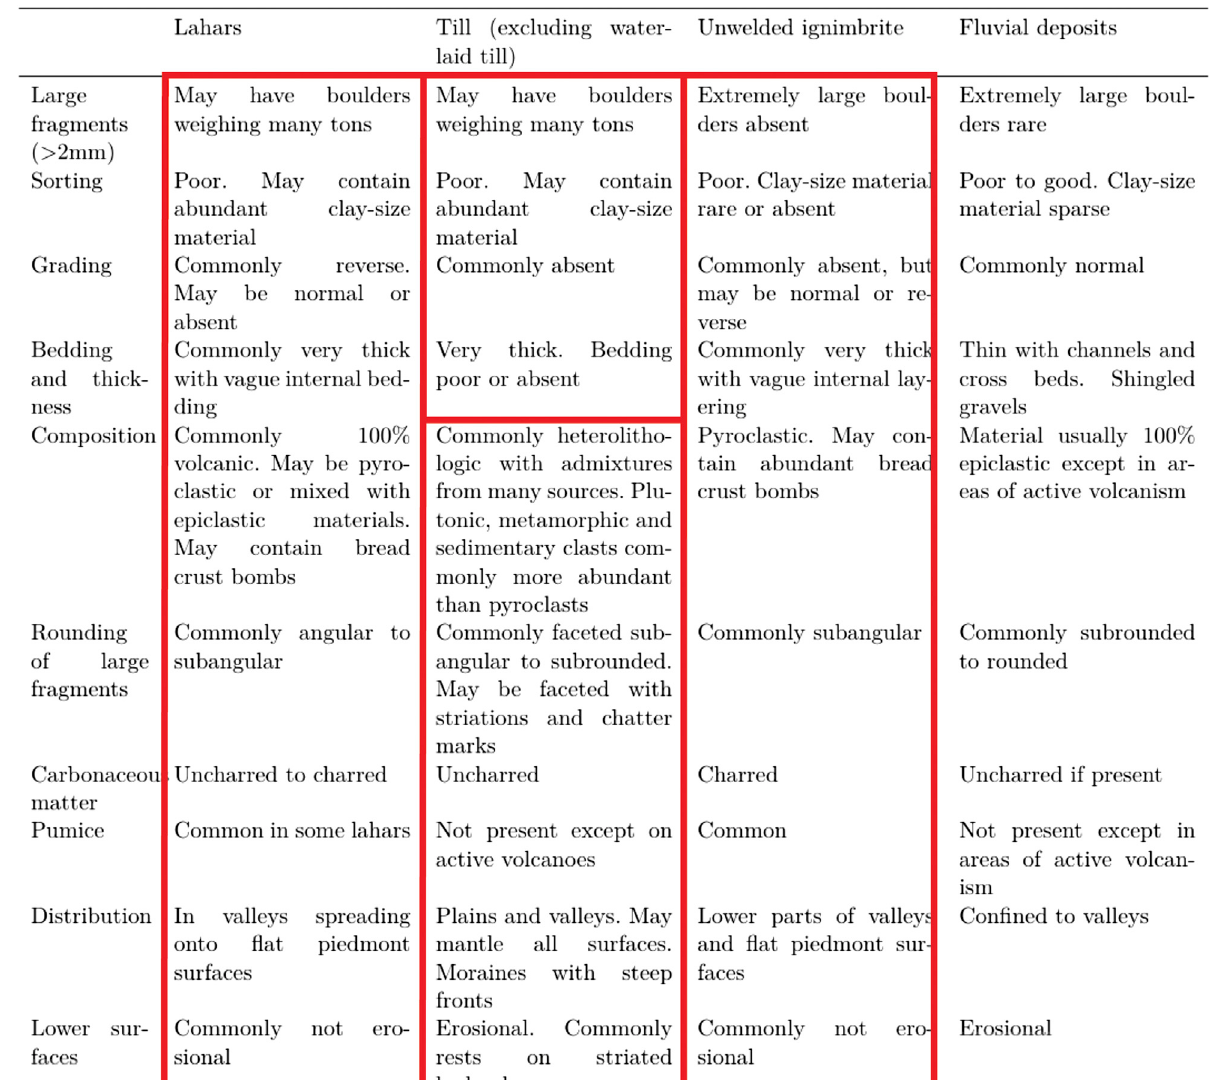
Frontiers in Earth Science |